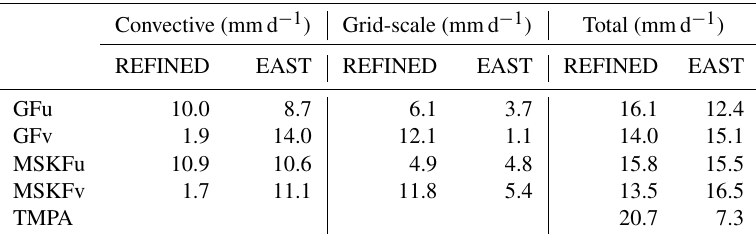
Table 3. Area-averaged convective, grid-scale, and total precipitation rates over the same areas as those described for Table 2. The REFINED and EAST areas are shown in Fig.